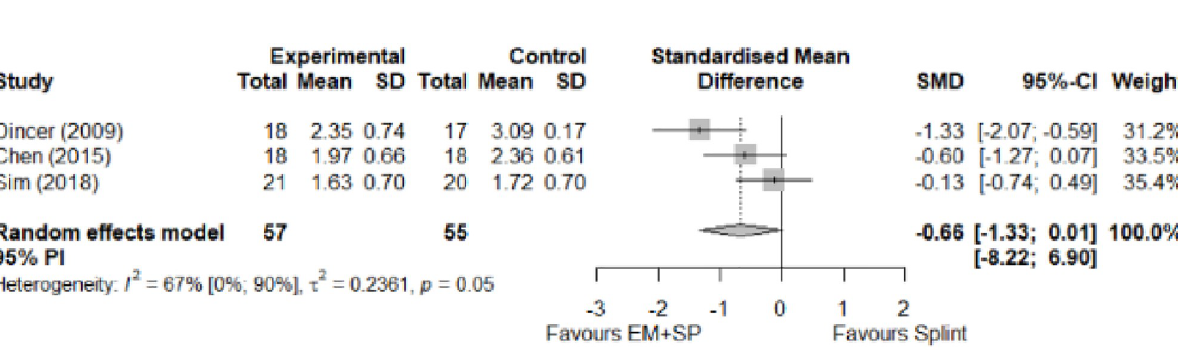
Fig 28. Analysis—Electrophysical modalities alone versus splinting (pain). Studies with more than two intervention groups (different modalities) were numbered as (1) and (2).